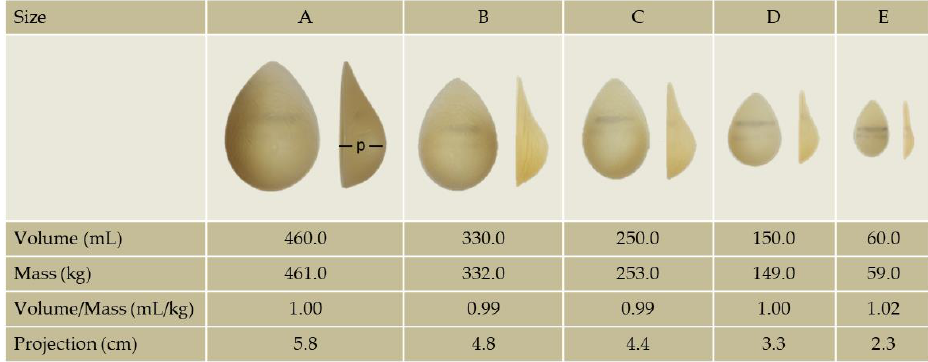
Figure 1. The sizes (A – E) and corresponding volumes, masses, volume/mass ratios and projections (p) of the external breast implants used in the study. Table 3. The means ± standard deviations and relative changes (augmented/natural) achieved (in parentheses) in the volume, mass, and projection of the natural and the artificially augmented by